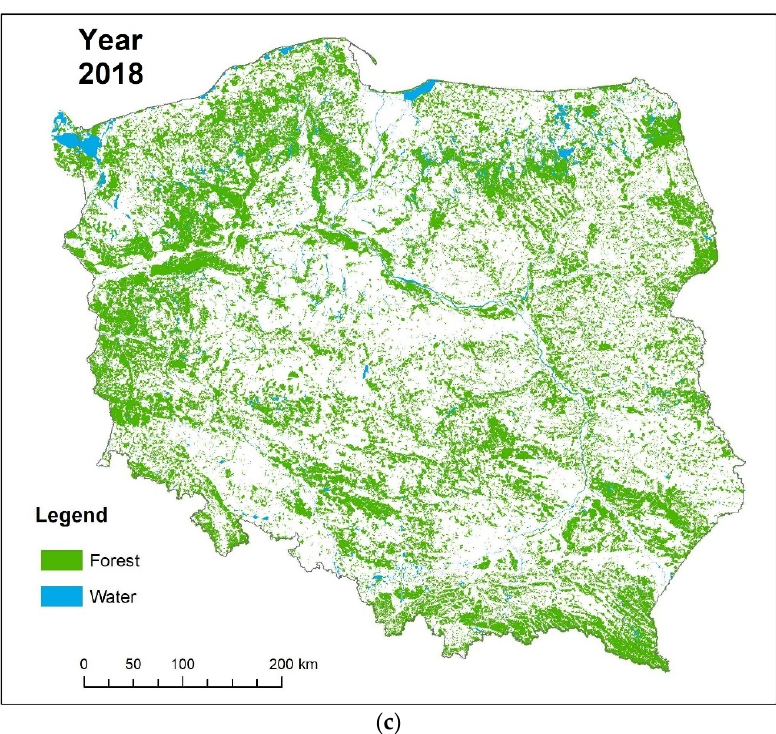
Figure 2. ( a ) Reconstruction of historic land cover of Poland in 1940 (based on [50]); ( b ) Reconstruction of historic land cover of Poland in 1990 (based on [50]); ( c ) Forest cover of Poland in 2018 (based on [51]).